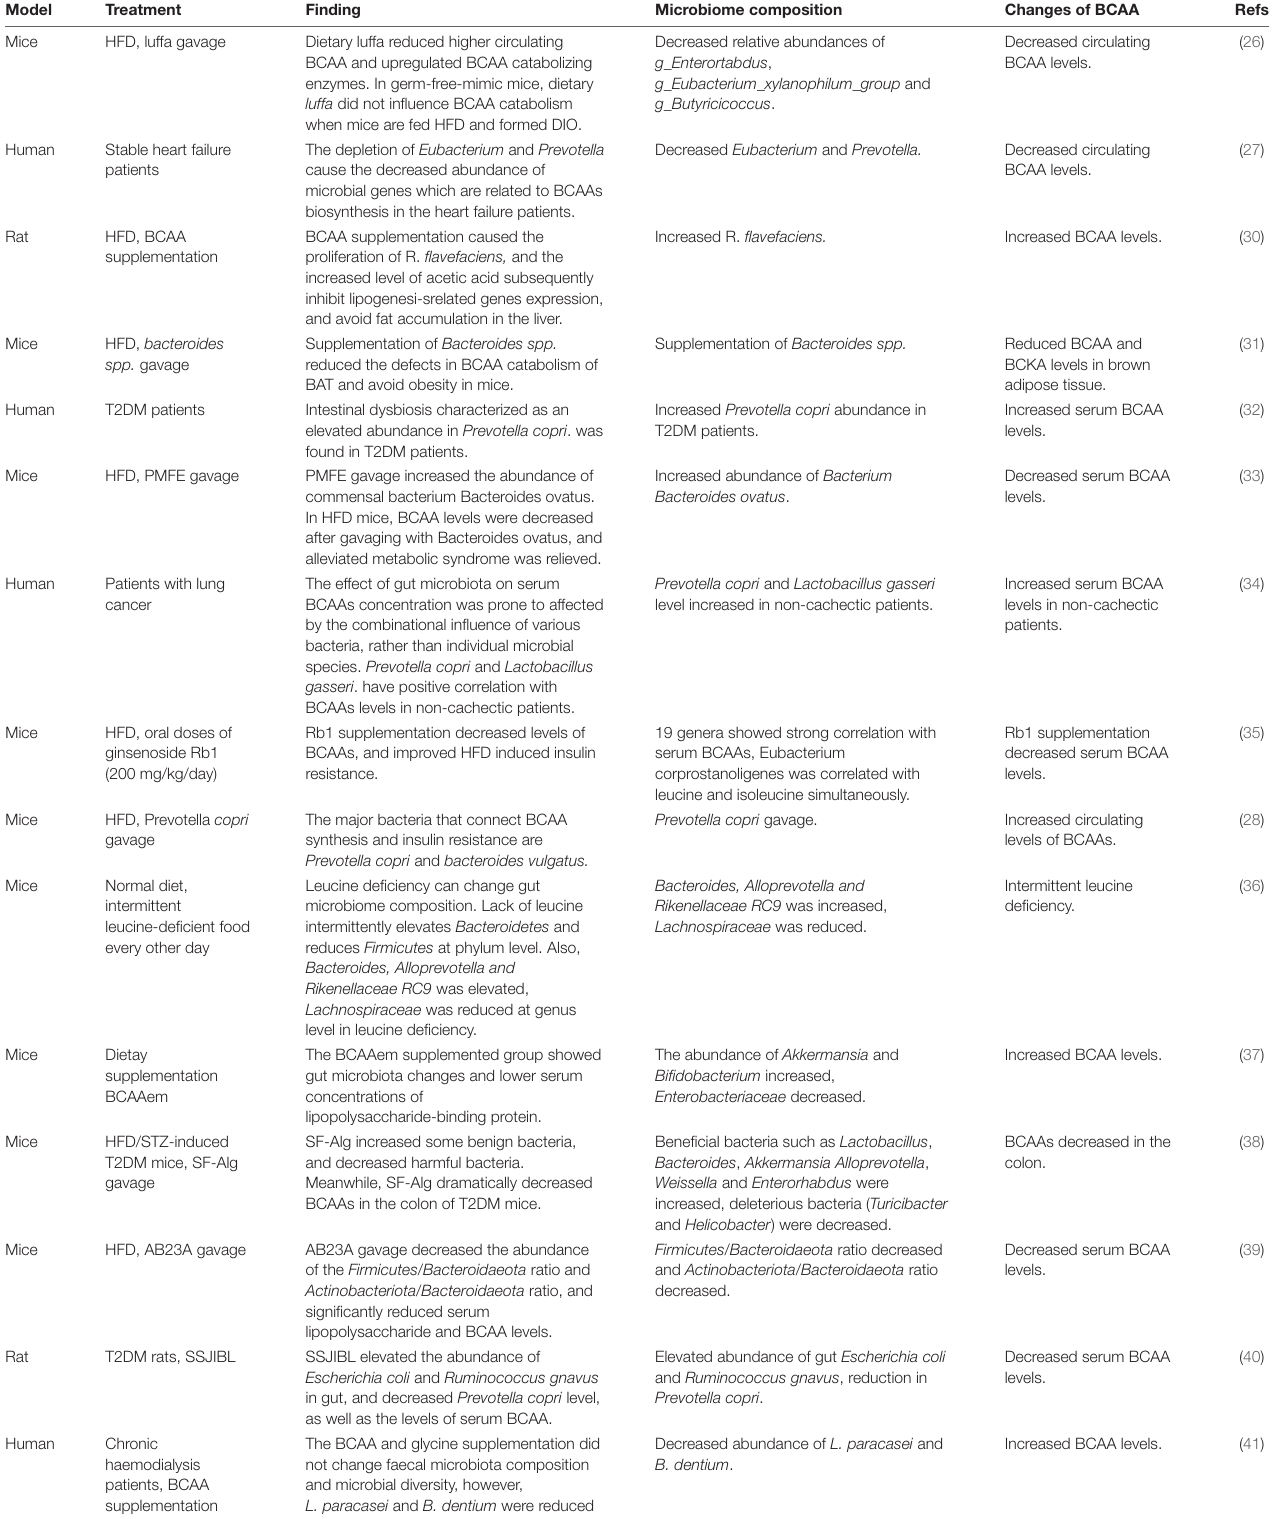
TABLE 1 | Summary of the interaction between microbiota and BCAA levels in different experimental settings from the recent